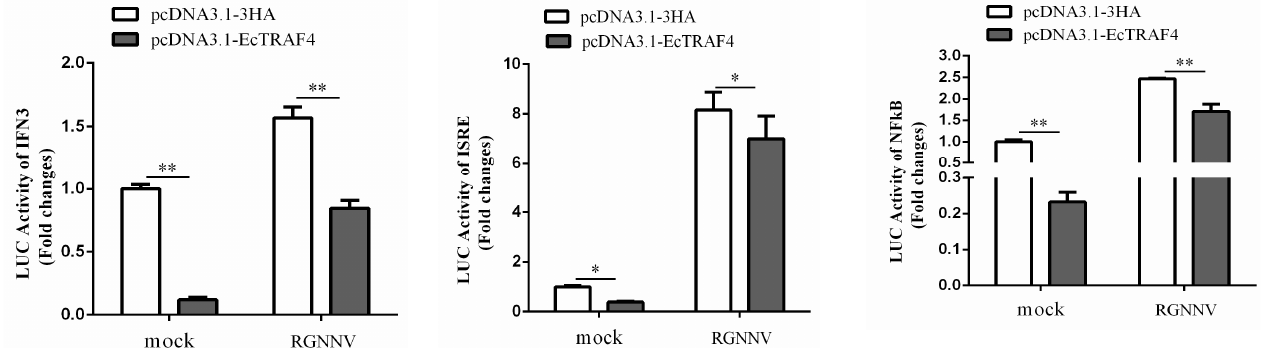
Figure 9. The relative luciferase activity of IFN, ISRE, and NF- κ B promoter in EcTRAF4-overexpressing cells. GS cells were co-transfected with NF- κ B-Luc/IFN- β -Luc/ISRE-Luc, pEGFP-C1, and pEGFP-EcTRAF4. Twenty-four hours after transfec- tion, cells were infected with RGNNV or left uninfected for 20 h before luciferase assays were performed (means ± S.E., n = 3). Asterisk denotes a significant difference (* p < 0.05 and ** p < 0.01).